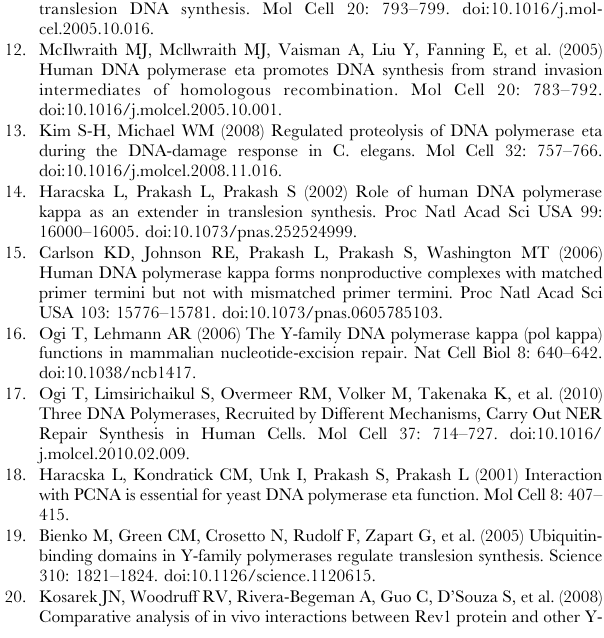
Figure S2 Germline sensitivity of polh-1 (lf31) and polh-1 (ok3317) mutants combined with repair defective backgrounds to different sources of DNA damage. (A–B) sensitivity to UV irradiation. (B) Epistasis analysis for xpa-1 and polh-1 . (C) Sensitivity to cisplatin. (D–F) Sensitivity to c -irradiation. (A)(C)(D) Both alleles of polh-1 lead to equal sensitivity to various damaging agents. (E–F) Epistasis analysis of polh-1 (lf31) and brc- 1(tm1145) mutants for c -irradiation. Data have been normalized for reduced survival (about 95%) in polh-1;brc-1 double mutants without treatment. Results of representative experiments are shown for A, C, D and F. Error bars denote SD. Each line in B and E represents the mean of minimal three independent experiments. Error bars denote the s.e.m. Figure S3 Development of L1 larvae three days after treatment with indicated UV doses. Percentage of animals in the different larval stages (L1-L2-L3-L4-young adult) was quantified 72 hrs after exposure to UV-irradiation. Figure S4 Apoptosis in the germline after UV-irradiation. (A) A transgenic line expressing pLim7::ced1::GFP is used. Examples of CED1-GFP engulfed cells in the germline bend are indicated with arrows. (B) Quantification of CED1-GFP engulfed cells. In the polh-1(ok3317) mutant apoptosis is slightly increased after exposure to UV irradiation. About 40 germlines have been analysed per sample. Error bars denote s.e.m. Figure S5 c -irradiated hermaphrodites were crossed with non- irradiated males carrying a Pmyo-2::GFP transgene. Lethality induced by c -irradiation is almost fully rescued in the cross progeny of polh-1 , but not brc-1 hermaphrodites. Figure S6 POLH-1 and POLK-1 in cellular tolerance to MMS during embryogenesis and L1 outgrowth. (A) MMS sensitivity of N2 and polh-1(ok3317) mutants with or without depletion of POLK-1 by RNAi. (B) Development of larvae exposed to MMS